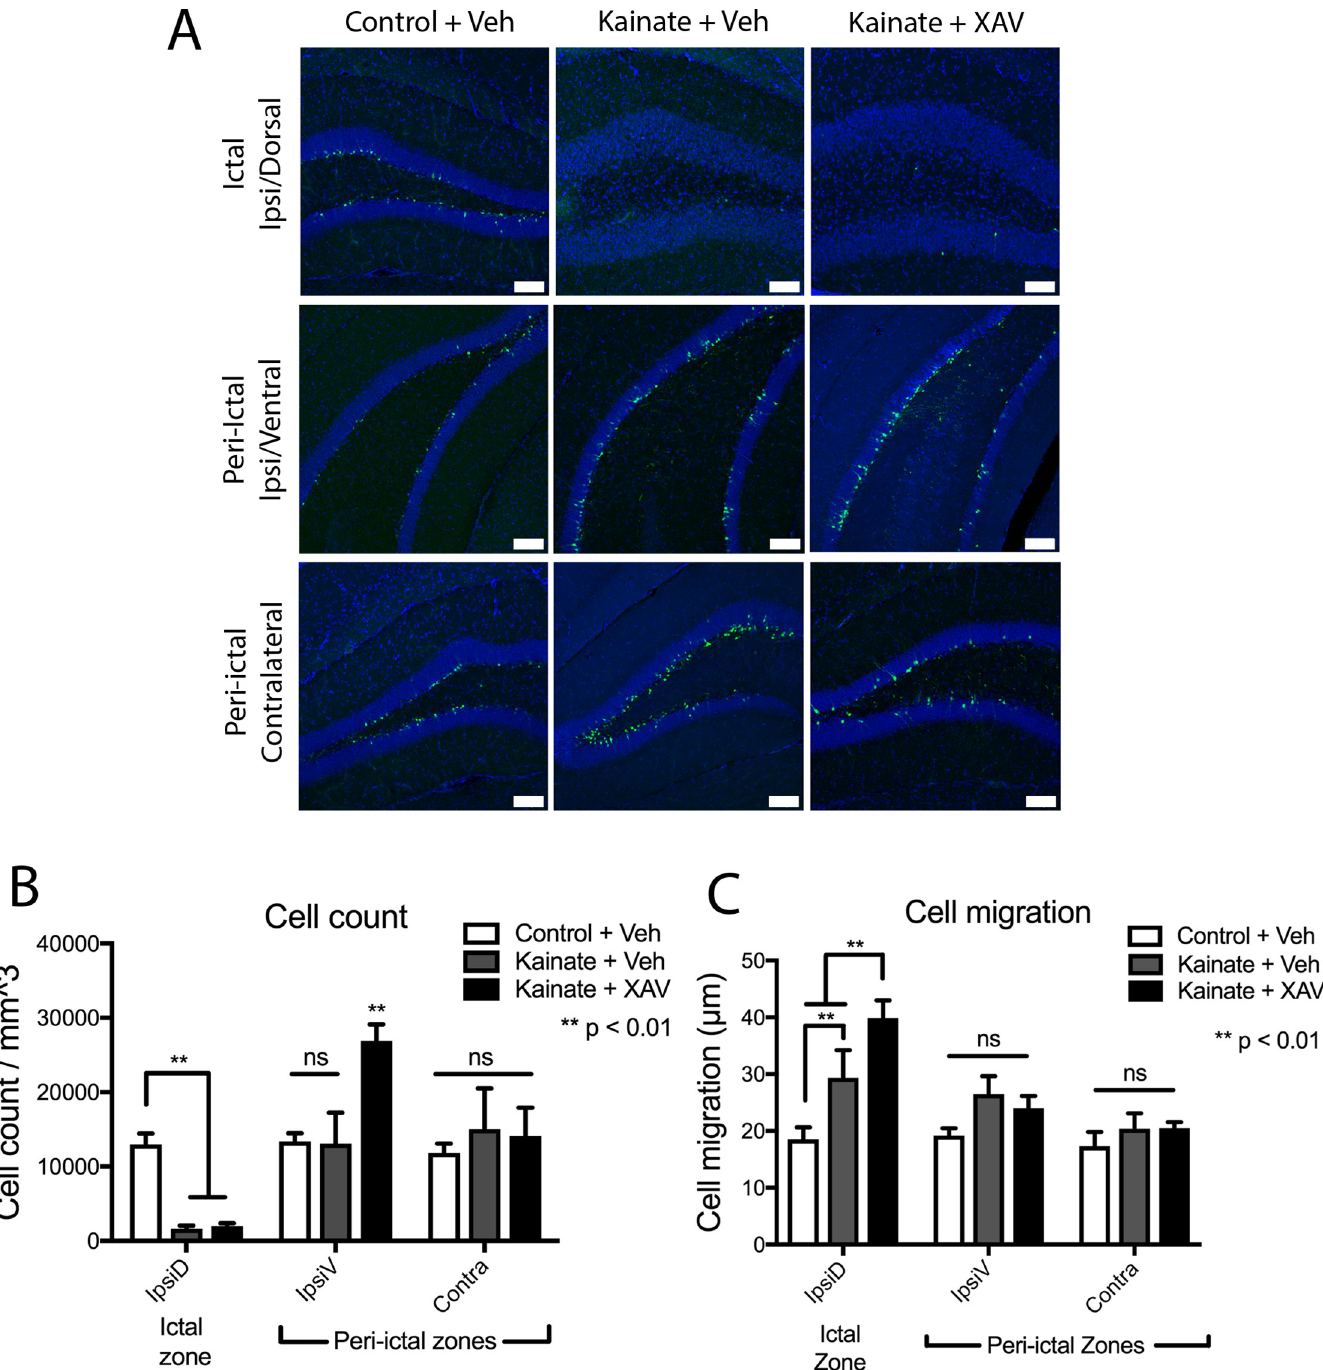
Fig 5. Modulation of neurogenesis and cell migration by the Wnt antagonism. (A) POMC-EGFP + newborn dentate granule cells 2wks after kainate-induced seizure, followed by vehicle or XAV939 treatment, in ictal and peri-ictal regions. Scale bars 100 μ m. (B) Newly born ( POMC-EGFP +) granule cell density decreased in the ictal zone, and was not rescued by XAV939 treatment. In the ipsilateral peri-ictal region, cell density increased after XAV939 treatment only in kainate-treated mice. No XAV939-induced change in cell density was observed in the contralateral dentate. (C) Newborn dentate granule cell migration increased in the ictal zone 2wks after seizure induction, which was further increased by XAV939 treatment. Cell migration was unchanged after kainate in the peri-ictal zones.